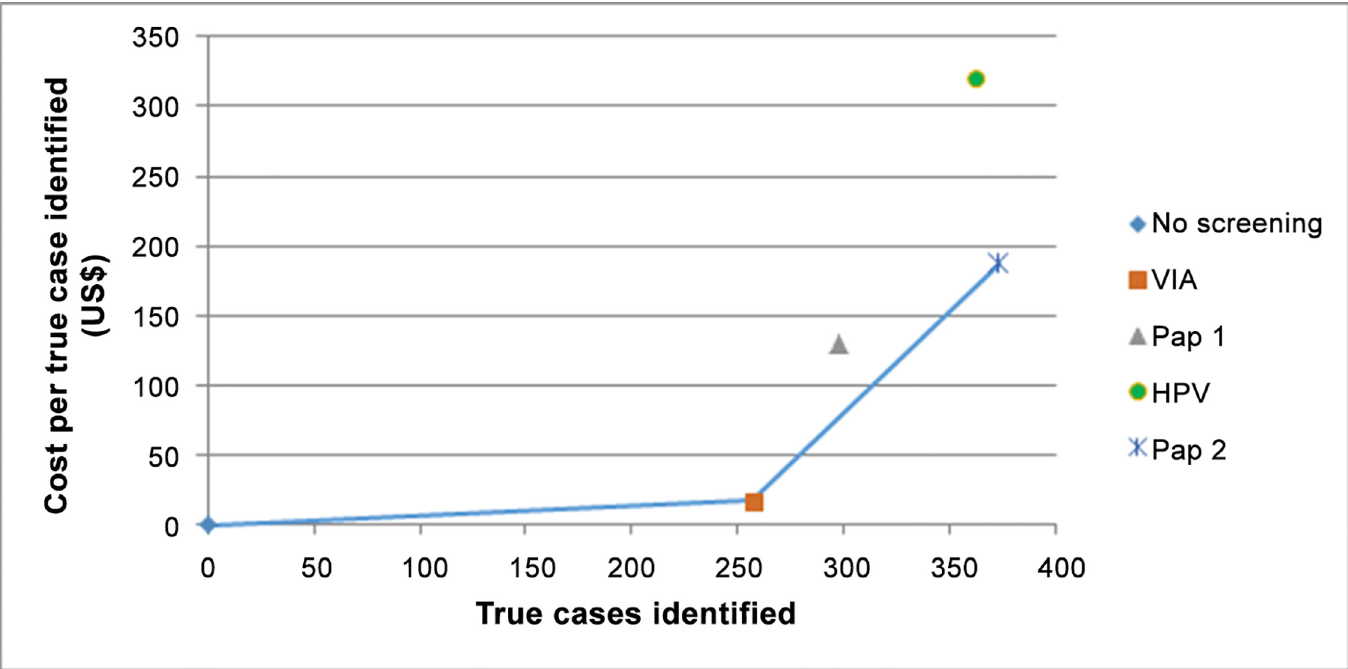
Fig 3. Comparison of screening methods: True cases of CIN2+ detected by cost per case. NB: The line represents the cost-effectiveness threshold, or frontier. All interventions or combinations of interventions along this line are more cost effective than intervention or combination of interventions left of the